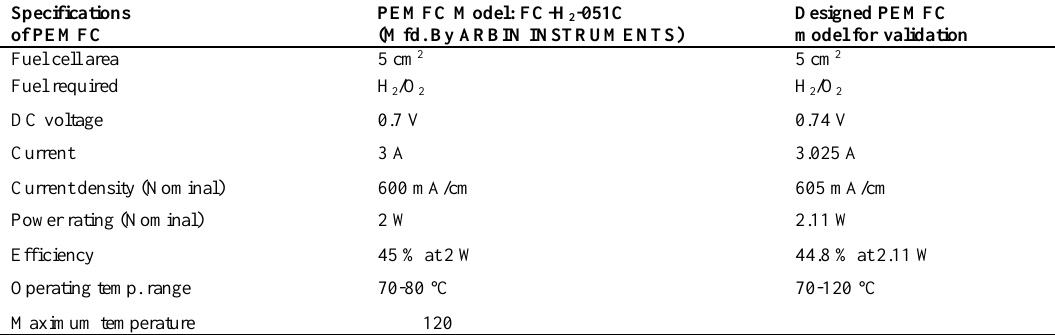
Table 3. Single PEMFC model performance (Pachauri and Chauhan, 2015) Specifications of